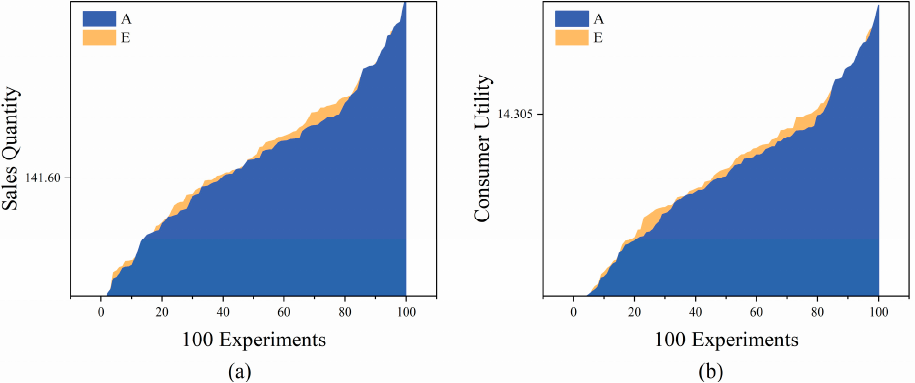
Figure 16. ( a ) Sales quantity and in A and E; ( b ) consumer utility in A and E. ( t = 100).